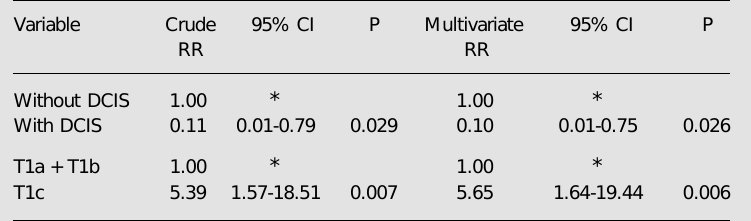
*Reference categories. See legend to Table 3 for tumor size